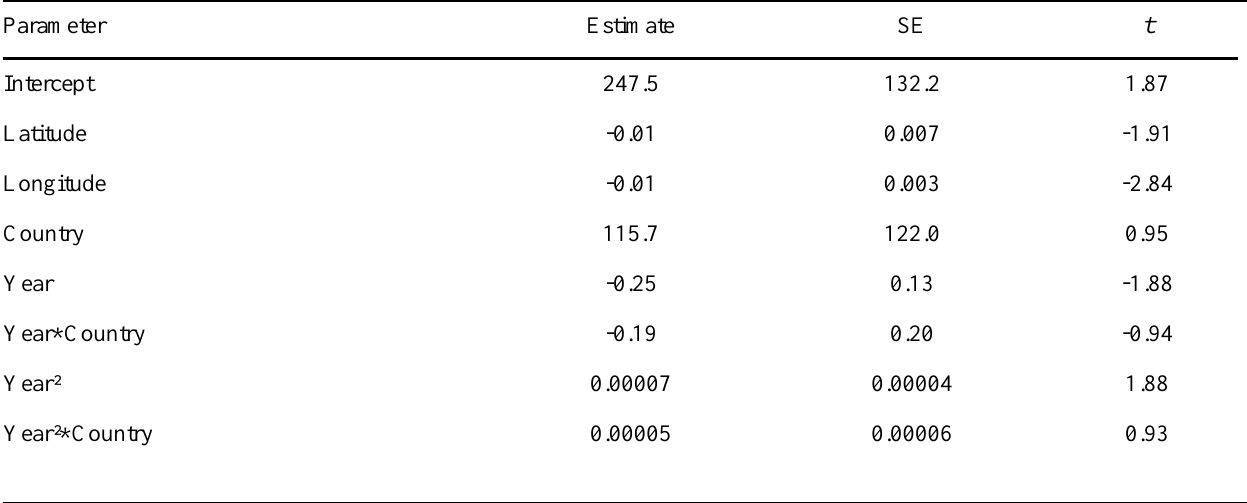
Table 3 . Model-averaged parameter estimates based on six general linear models relating the nest success of dabbling ducks as a function of latitude and longitude, country (Canada vs. the United States), and year in the North American Prairie Pothole Region between 1935 and 2006. SE refers to standard error, and t = estimate/SE. Parameters in which t > 1.96 have 95% confidence intervals that do not include 0. Parameter Estimate SE Intercept Latitude